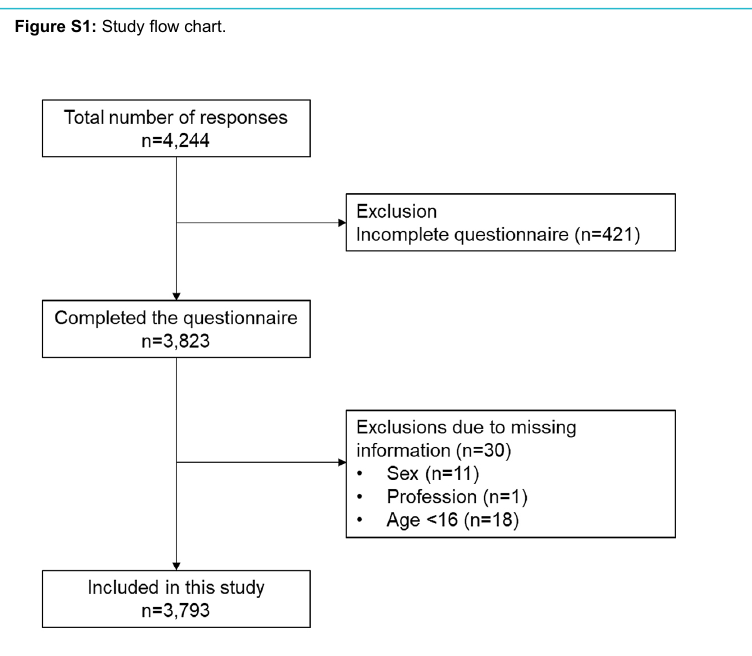
Figure S1: Study flow